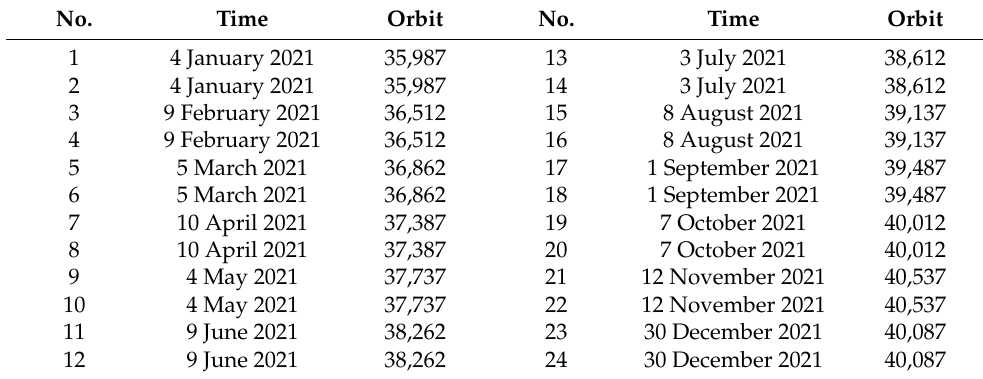
Table 2. Detailed Sentinel-1 data.